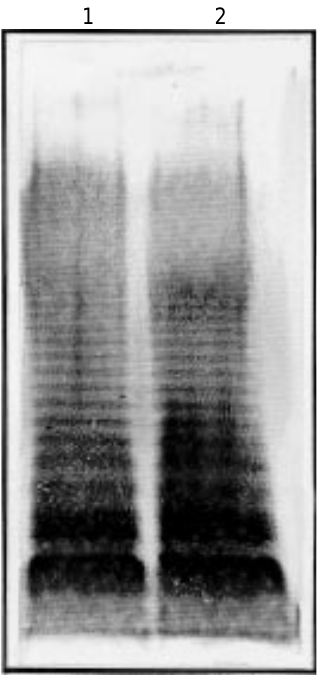
Figure 2 - Lipopolysaccharide composition of S. typhimurium SL3261 and HG3 strains. Bacte- ria grown in LB (about 10 7 cells) were treated with proteinase K and subjected to SDS-PAGE, fol- lowed by silver staining of